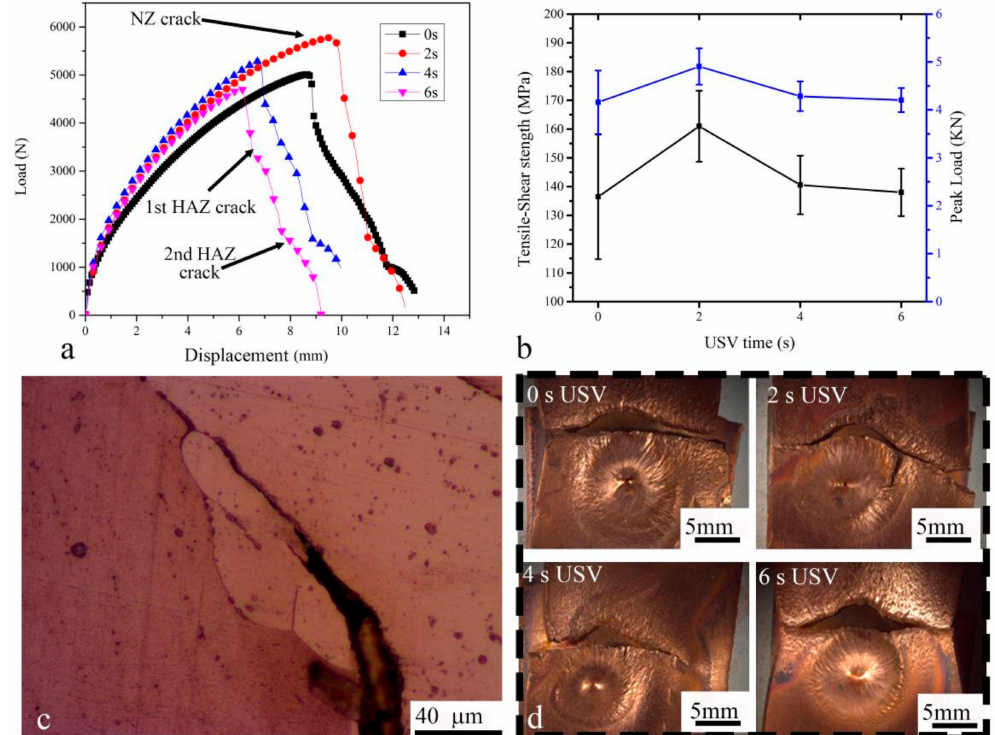
Figure 10. GTA spot-welded joints behavior with different times of USV (0, 2, 4, 6 s) tested in a tensile-shear test: ( a ) typical load-displacement curves; ( b ) tensile-shear strength and peak load vs. USV time; ( c ) the micro-solidification crack for a cross-sectioned sample welded with 6 s USV; and ( d ) the fracture